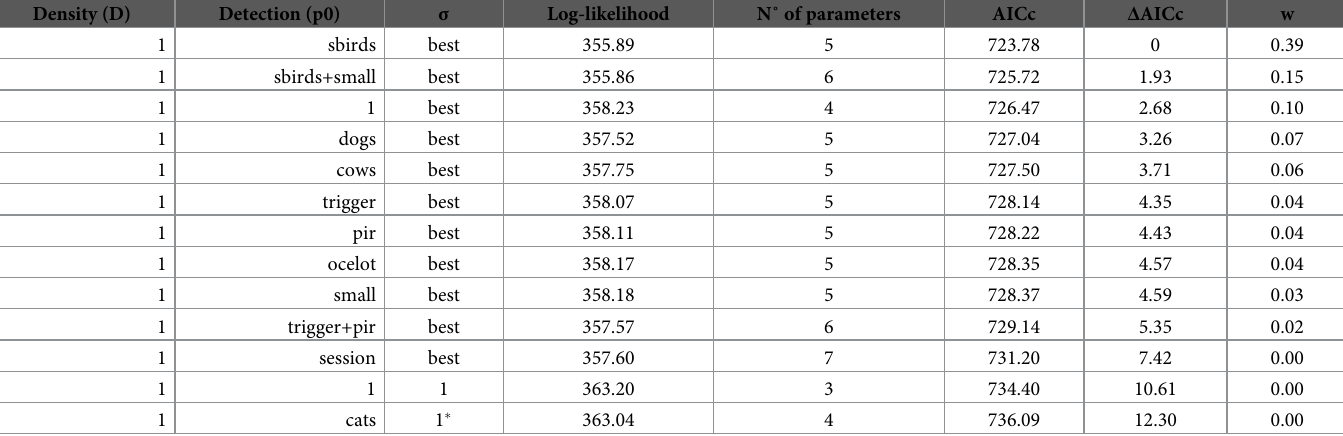
Table 3. Candidate set models evaluating the role of covariates on rate of detection (p0) of margay ( σ : Spatial scale, AICc: Akaike Information Criteria for small sample sizes; Δ AICc: Difference between AICc of each model and the model with the lowest AICc; w: Weight). Density (D) Detection (p0)